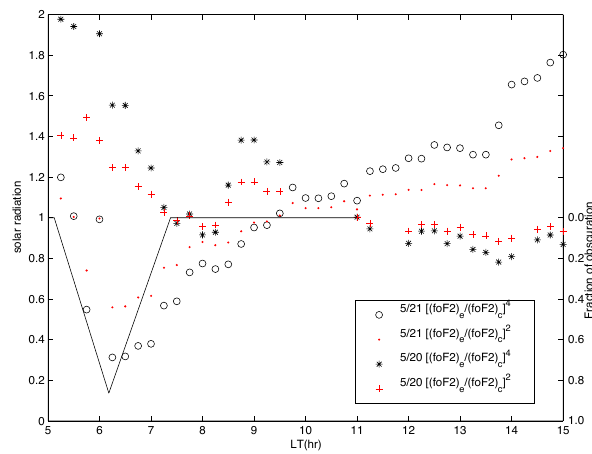
Figure 4. 3 Fig. 4. Variations in the fraction of obscuration (solid line), the sec- ond power (red dots and crosses), and the fourth power (circles and asterisk) of fo F 2 on 21 and 20 May 2012,